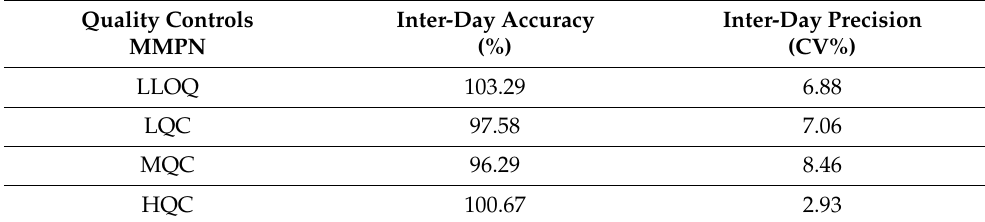
Table 9. Inter-day accuracy and precision (CV%) referred to QCs of MMPN.